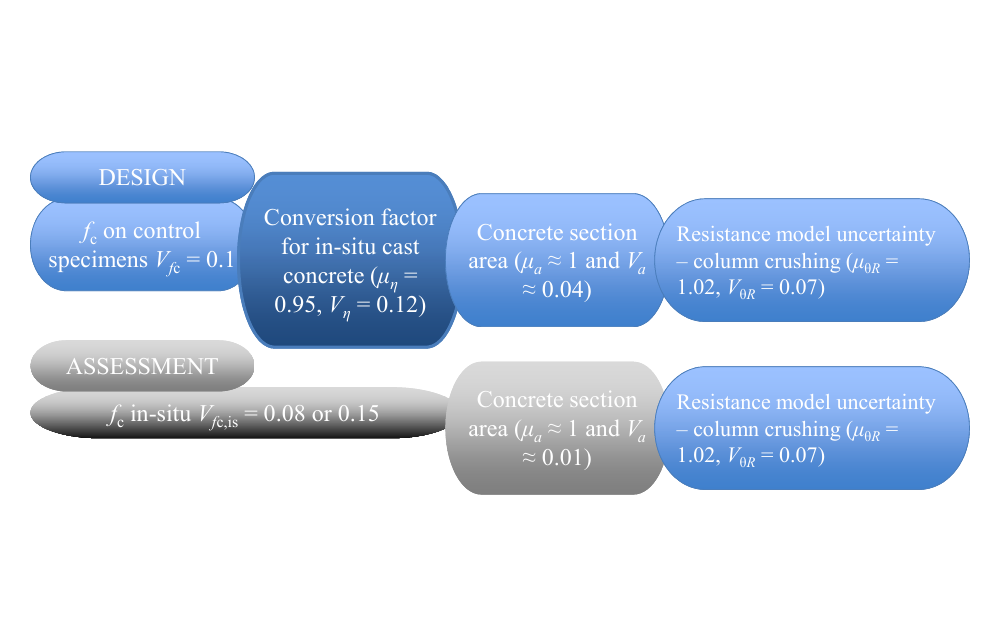
Figure 1. Basic variables considered in resistance model for short columns in design and assessment situations.